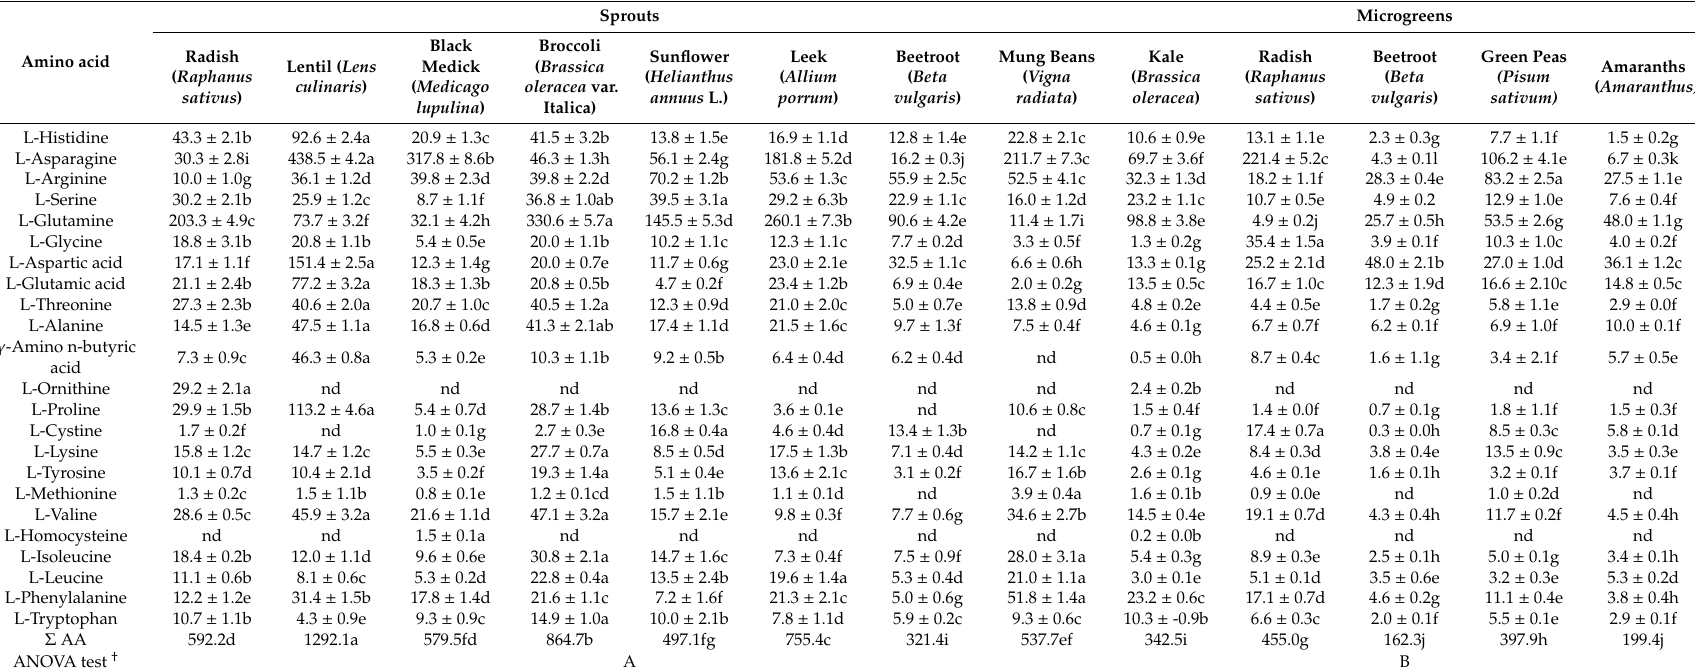
Table 3. Free amino acid (mg / 100 g fw) composition of sprouts and microgreens.